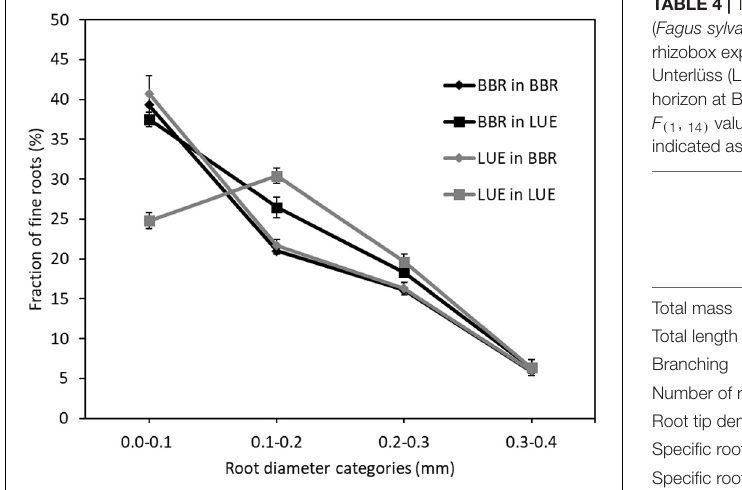
FIGURE 1 | Fractions of fine roots in different diameter categories in (%) of total length of fine roots with diameter ≤ 2 mm, as measured in August of the second growing season in a rhizobox experiment with beech ( Fagus sylvatica L.) saplings originating from the sites Bad Brückenau (BBR) and Unterlüss